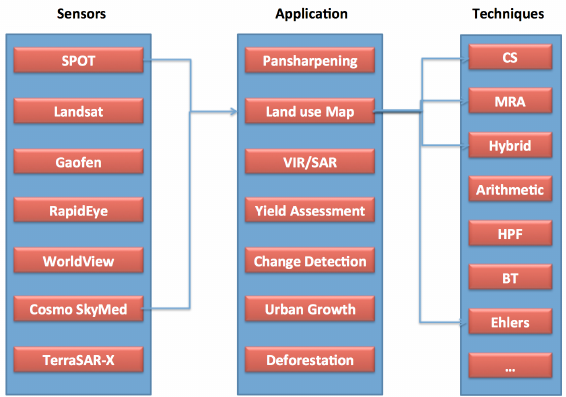
Figure 6. The arrows follow the rules stored in the